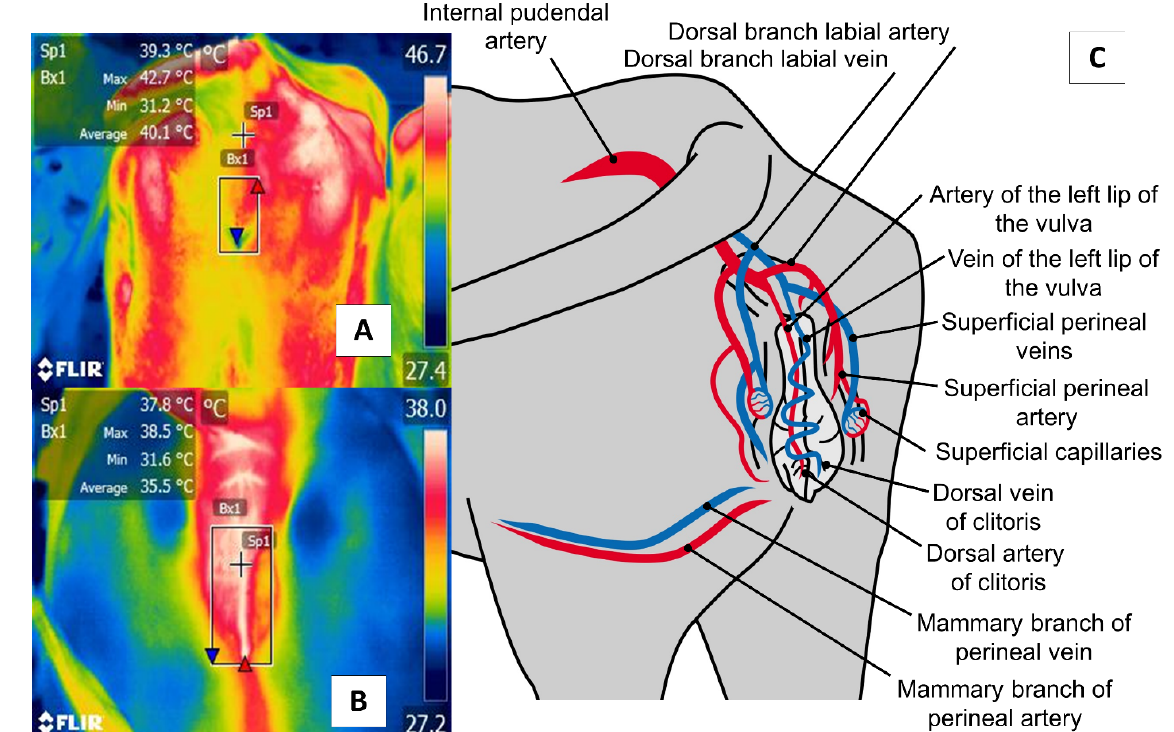
Figure 7. The perineal region ( regio perinealis ), especially vulvar thermal window, in dairy cattle ( Bos ) ( A ) and river buffaloes ( Bubalus bubalis ) ( B ). This window is marked by a square (Bx) placed from the coccygeal insertion of the vulva to the ventral commissure of this area, which permits taking readings of circulation from the internal pudendal artery ( C ). This artery emits capillaries in the vulvar labia that, during estrus, respond to increases in the concentrations of prostaglandin E2 α that cause vasodilatation of the capillaries and, with this, greater temperature irradiation during this physiological stage that permits the detection of estrus in a non-invasive manner.